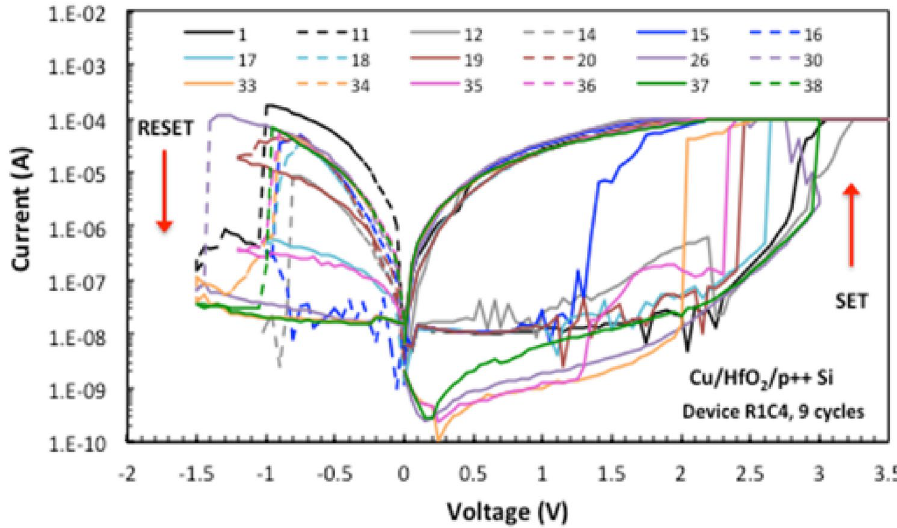
Figure 5. I–V characteristics obtained from one memristor device.